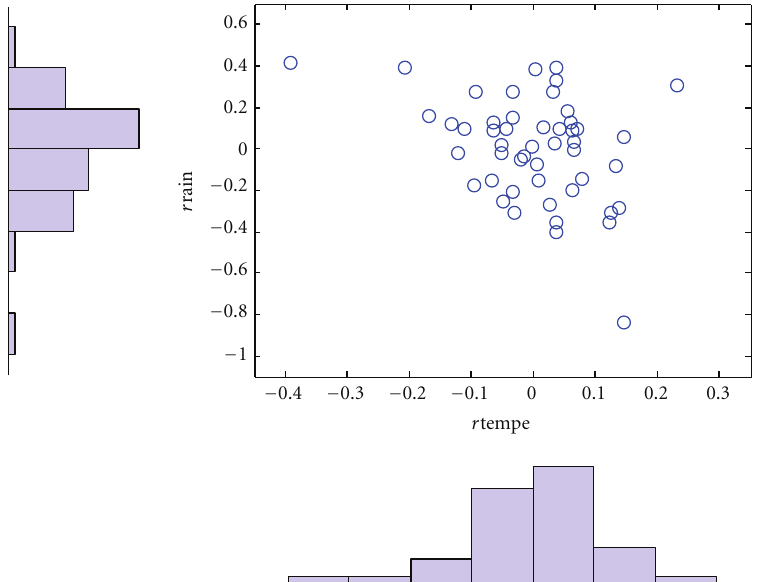
Figure 7: Scatters of residuals for trend adjusted temperature and rainfall in